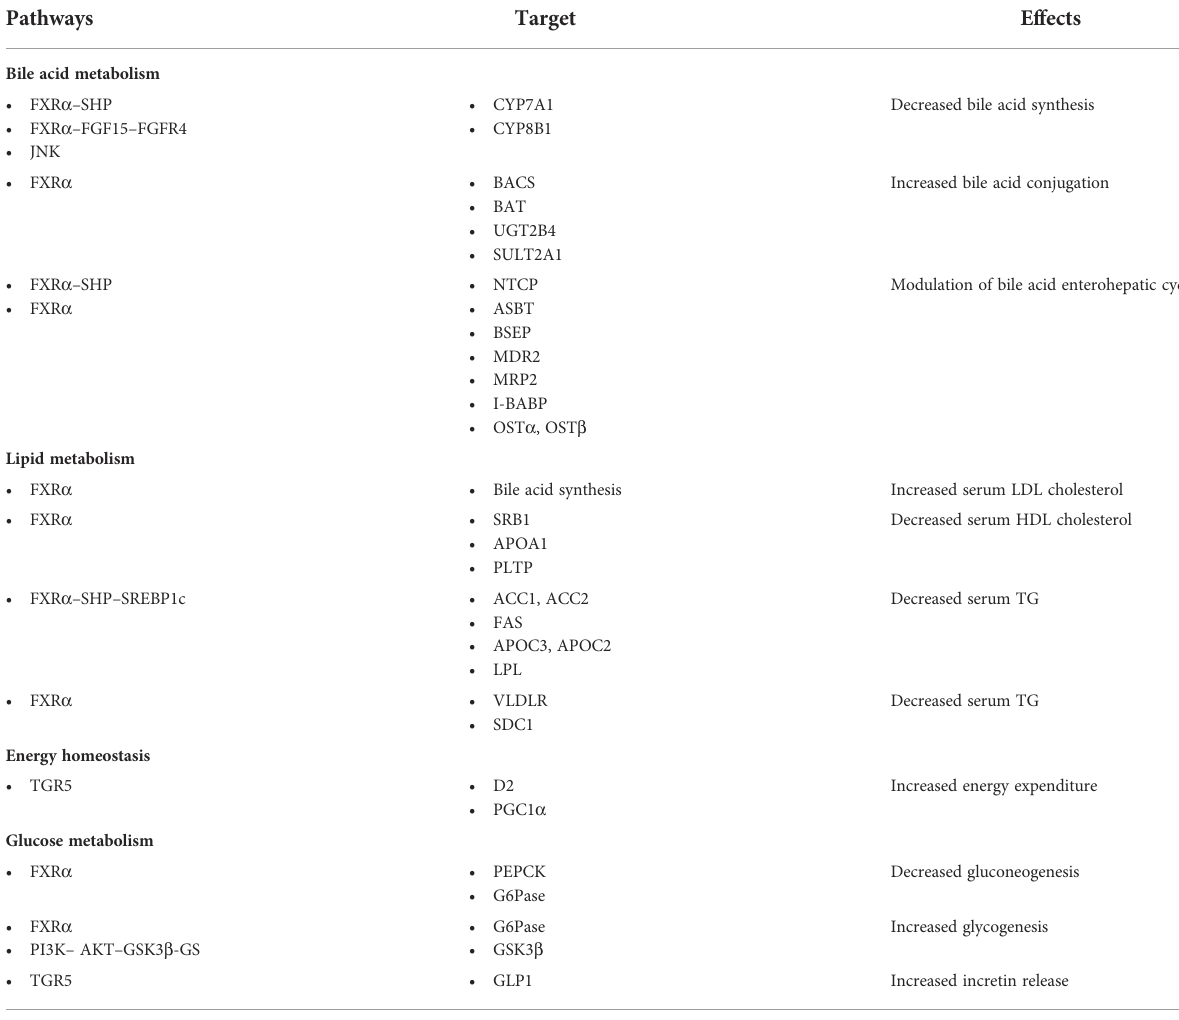
TABLE 1 Bile acid sensors, targets, and metabolic effects. Pathways Target Effects Bile acid